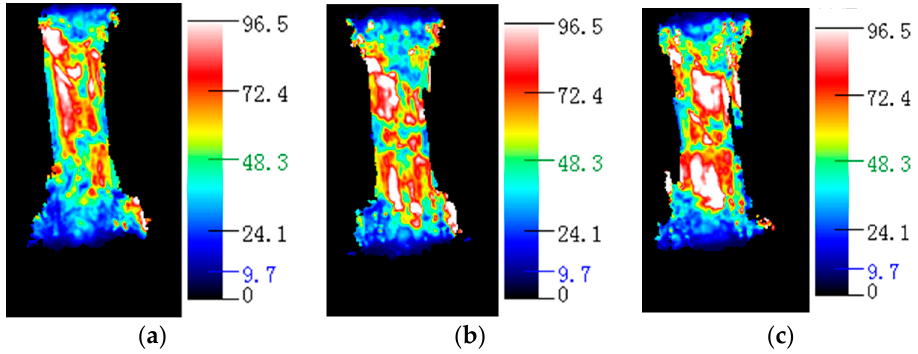
Figure 8. Ultrasonic test results of plain weave prepreg composite in different emission pressure of the striker. ( a ) 0.3 MPa. ( b ) 0.5 MPa. ( c ) 0.7 MPa.